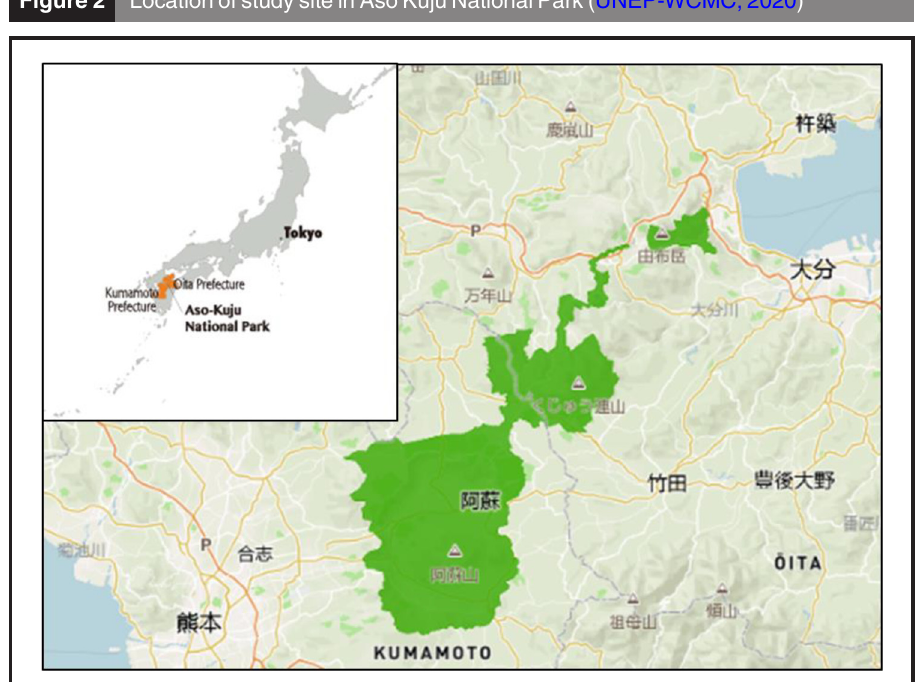
Figure 2 Location of study site in Aso Kuju National Park (UNEP-WCMC,